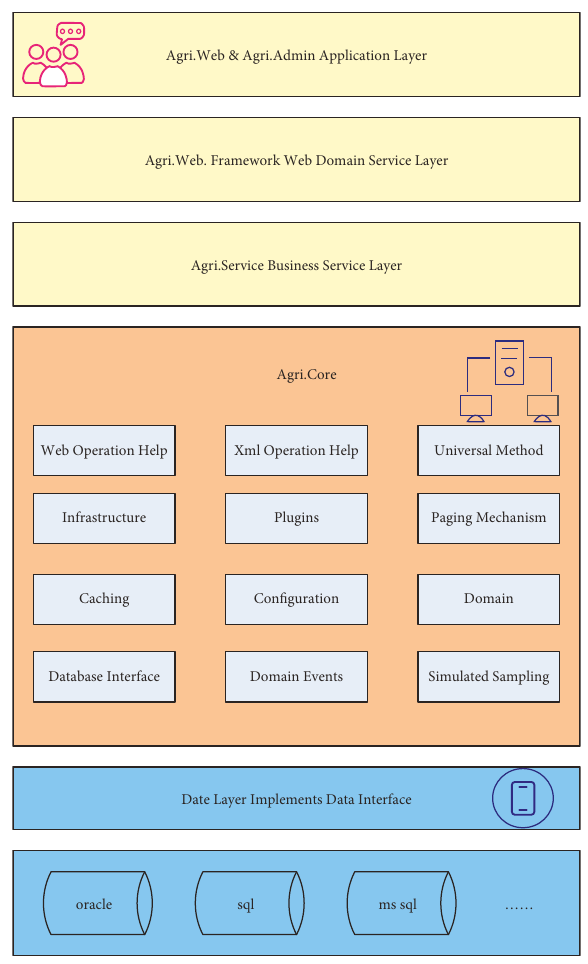
Figure 3: Information platform architecture hierarchy diagram.